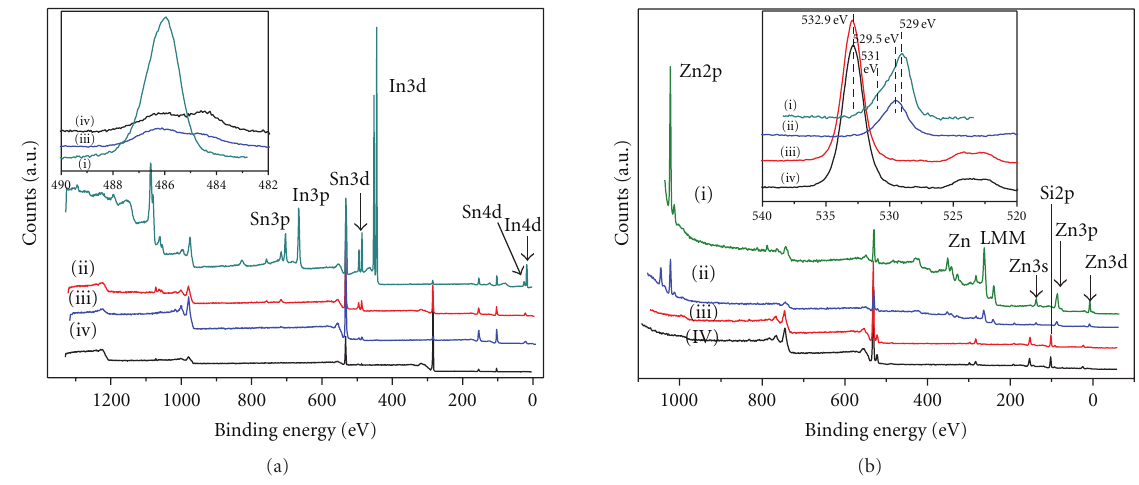
Figure 2: (a) XPS survey scan and Sn3d 5 / 2 spectra (inset) of (i) as-grown ITO film, (ii) after 30 minutes diamond growth on ITO substrate, (iii) after 1 hour hydrogen plasma treatment at 800 ◦ C, (iv) after two hours diamond growth on ITO substrate. (b) XPS survey scan and O1s spectra (inset) of (i) as-prepared AZO film, (ii) after 5 minutes and (iii) 10 minutes hydrogen plasma treatment at 800 ◦ C in an HFCVD reactor, (iv) after 30 minutes diamond growth on AZO